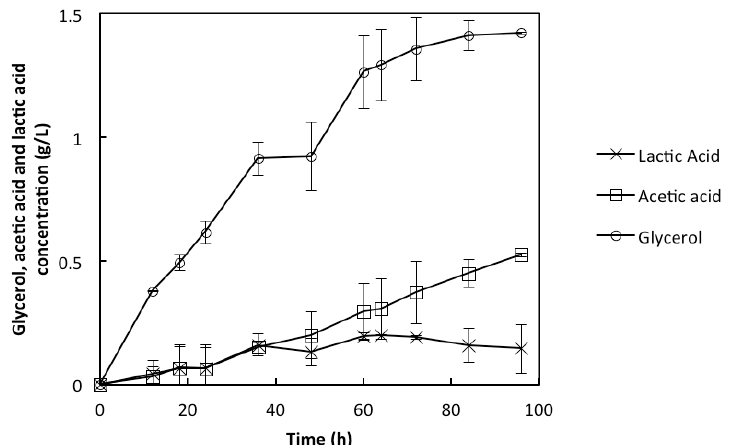
Figure 3. Concentration (g/L) profiles of glycerol, acetic acid, and lactic acid during the use of rMBR in the synthetic medium. Presented values are average values of two experiments, with error bars as the standard deviation between the two